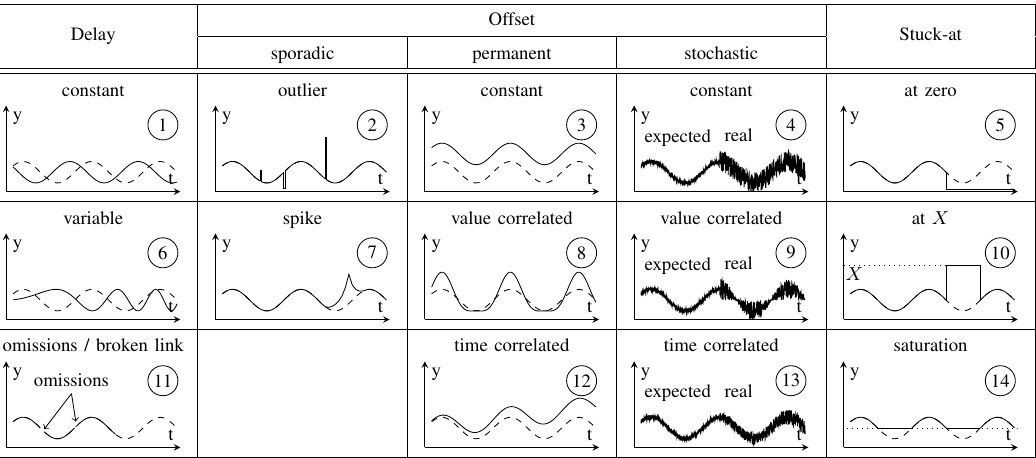
Figure 3. Sensor failure model defined by Zug et al.